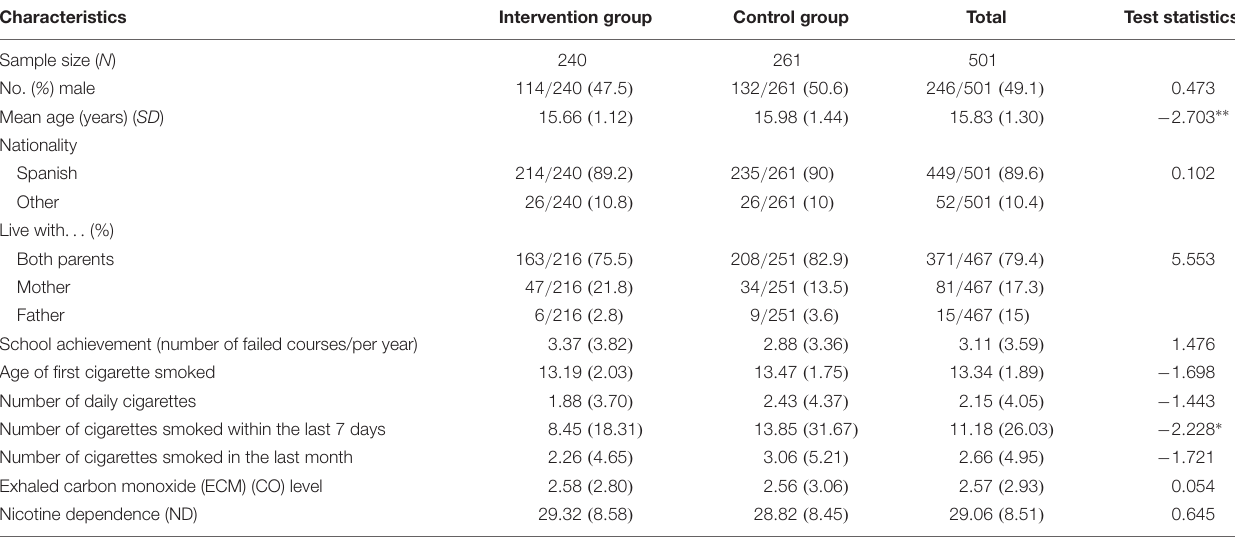
TABLE 2 | Baseline characteristics and reports of tobacco consumption measures at 12-month follow-up of participating Spanish adolescents by experimental condition. Characteristics